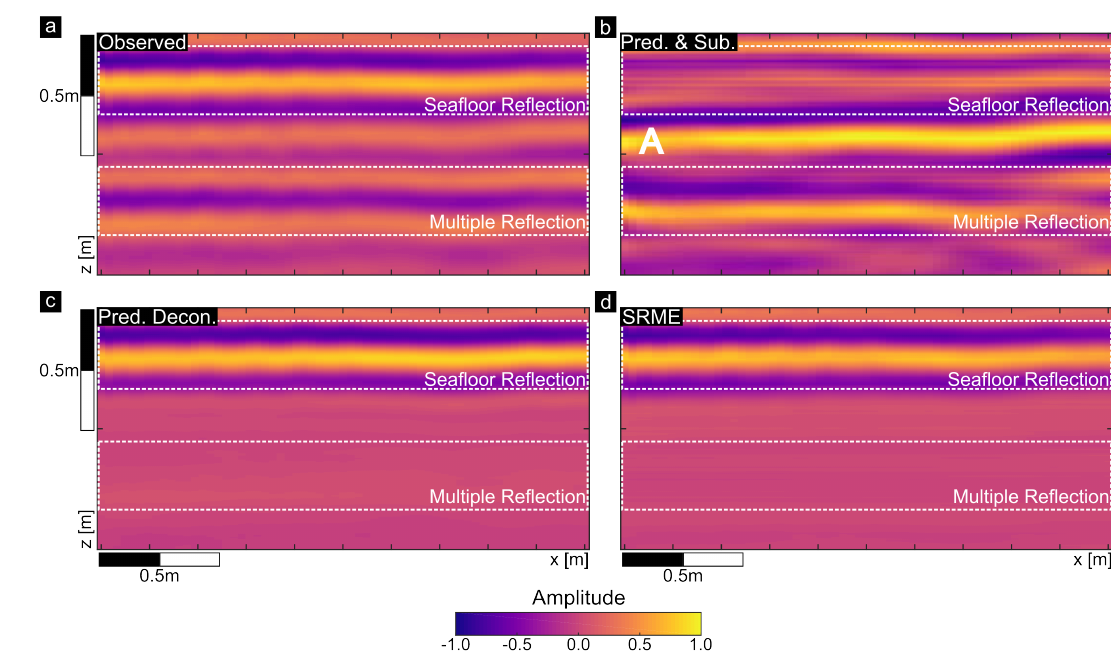
Figure A2. Detail 1 of multi-offset section of field data set 1 from Puck, Poland. The original data ( a ) and results of three multiple attenuation approaches are shown ( b – d ). The seafloor reflection and the first water-layer multiple are highlighted with white boxes. The enhanced reflector of method A is marked by a white A in panel ( b ).